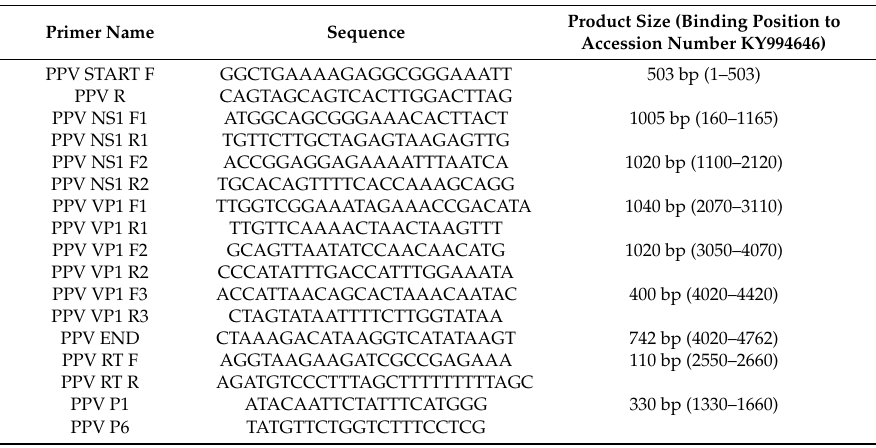
Table 1. Details of primers used in this